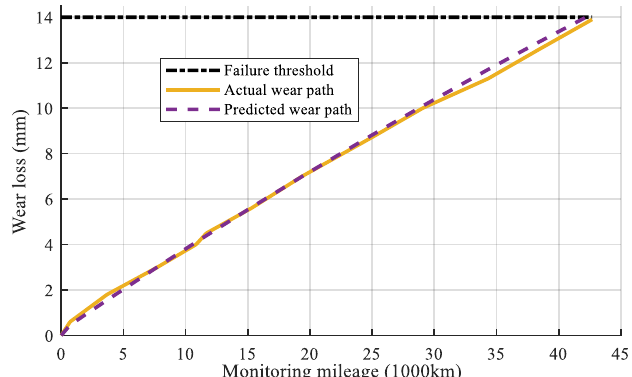
Figure 9. The conversion process.